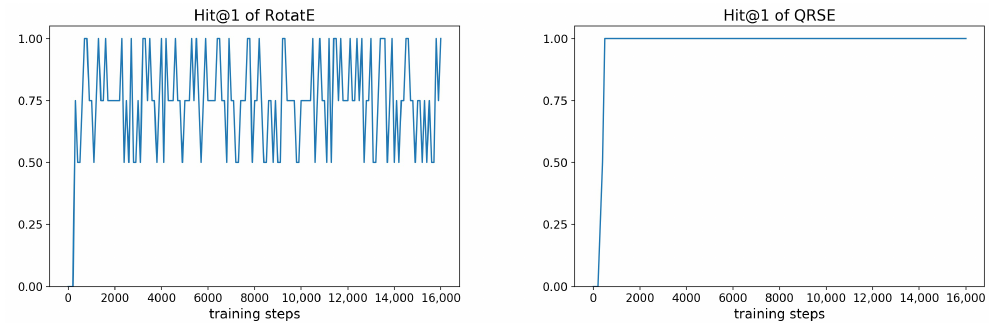
Figure 3. The Hit@1 performance of RotatE and QRSE on the test set along with the training process.